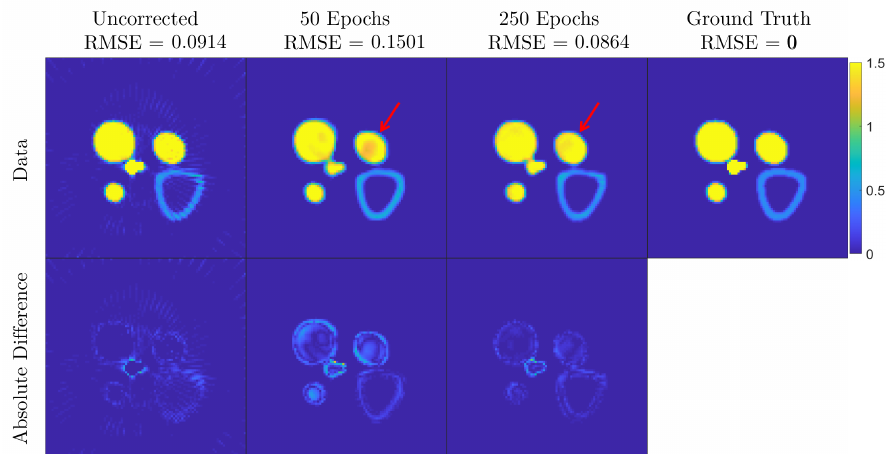
Figure 4. MAR correction analysis of a simulation test training data for different amounts of training epochs. The top row features the images for uncorrected data and corrected data, training the network for 50 and 250 epochs, and the ground truth as comparison reference. The bottom row features the absolute difference between the top adjacent images and the ground truth. The red arrow indicates the cupping artifact induced by the CNN correction when the network is trained for 50 epochs. This effect disappears when the network is trained for 250